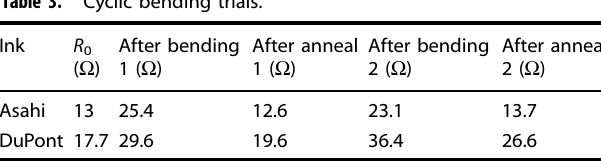
Table 3. Cyclic bending